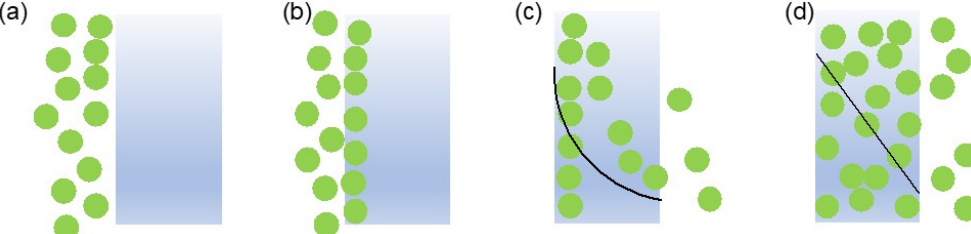
Figure 1. Graphic illustration of solution–diffusion model. ( a ) Upstream gas in contact with the membrane. ( b ) Dissolution of gas molecules into the surface of the membrane. ( c ) Diffusion of gas molecules through the membrane due to concentration gradient. ( d ) Gas molecules reached diffusion equilibrium with a linear concentration gradient through the membrane.